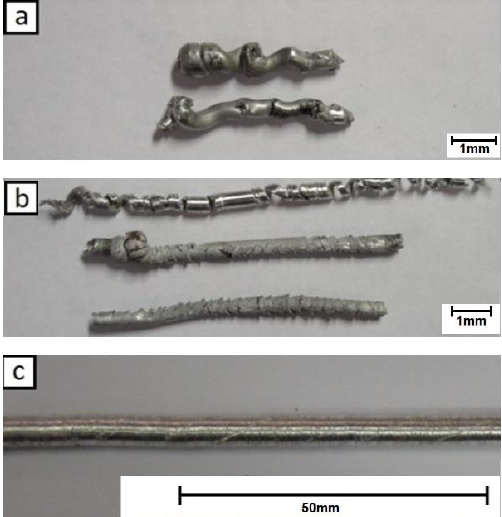
Figure 3. Extrusion experiments with re-melted castings (RM) alloy: ( a ) 80 rpm, ( b ) 160 rpm and ( c ) 224 rpm (all presented at the same scale).